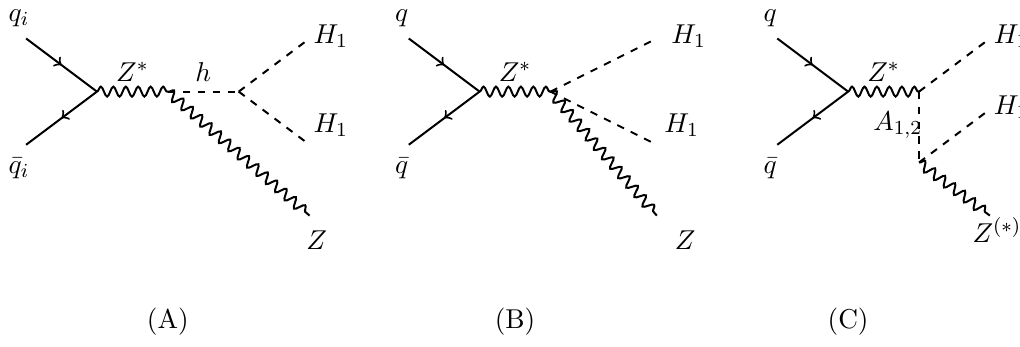
Figure 7 . Diagrams leading to the (cid:0) E T f (cid:22) f (cid:12)nal state via the H 1 H 1 Z ( (cid:3) ) intermediate